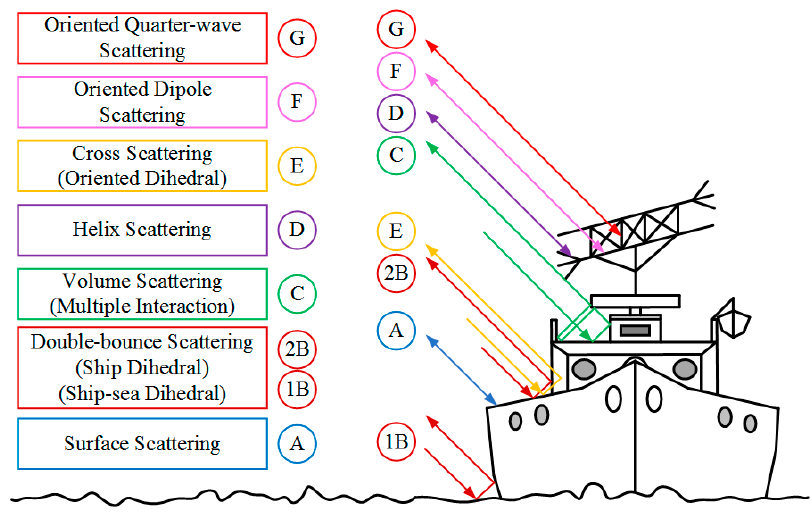
Figure 2. Various types of scattering occurring on a ship.